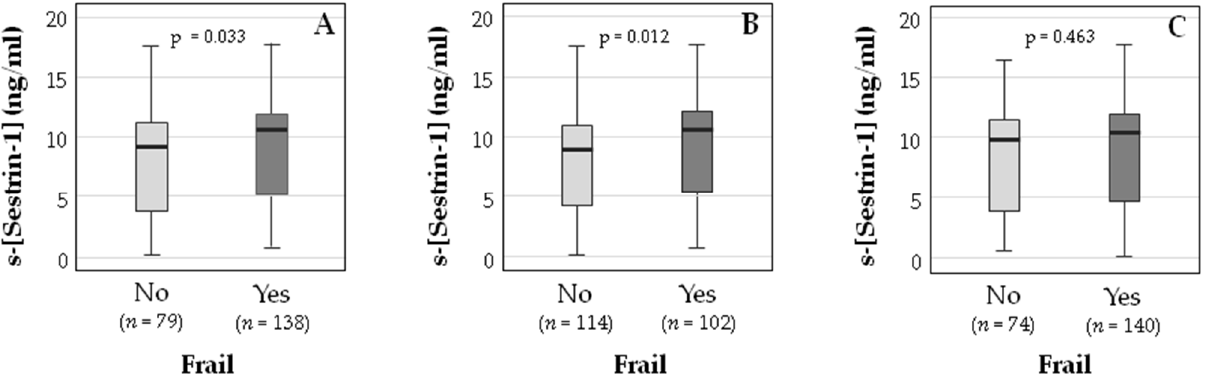
Figure 1. Medians and interquartile ranges of the serum sestrin-1 concentration (s-[Sestrin-1] (ng/mL)) in frail and non-frail participants following the Fried Frailty Phenotype ( A ), the Clinical Frailty Scale ( B ), and the Tilburg Frailty Indicator ( C ) criteria.